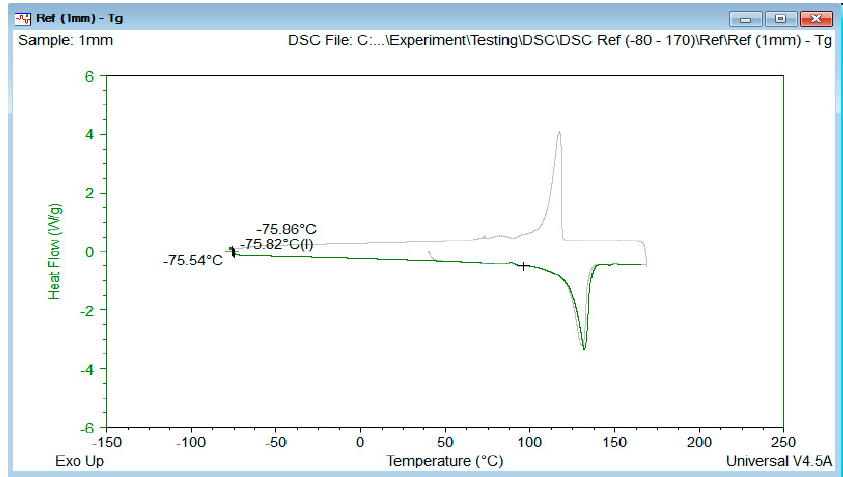
Figure A1. T g of virgin HDPE.